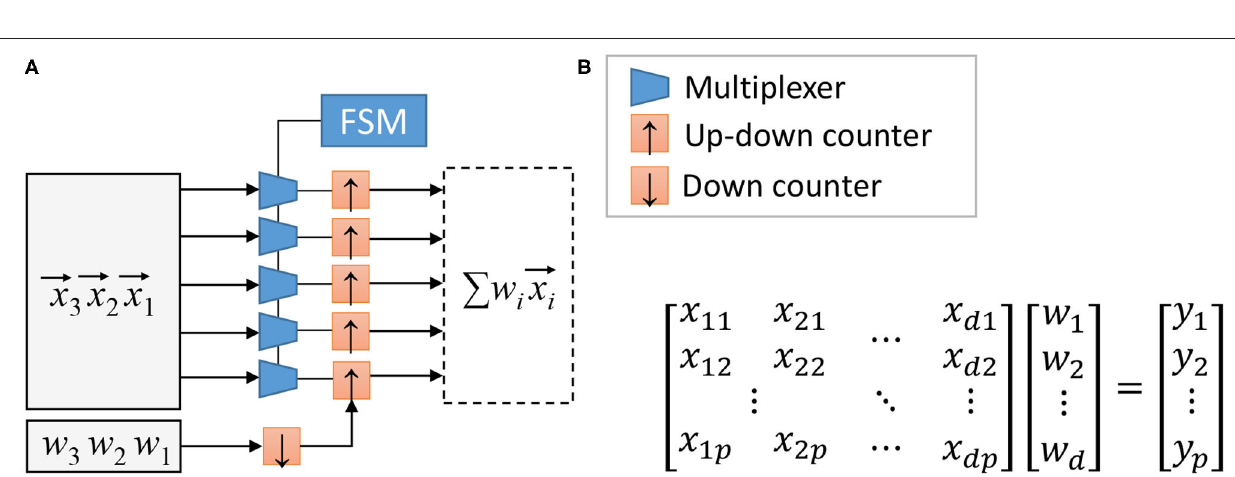
Frontiers in Neuroscience |